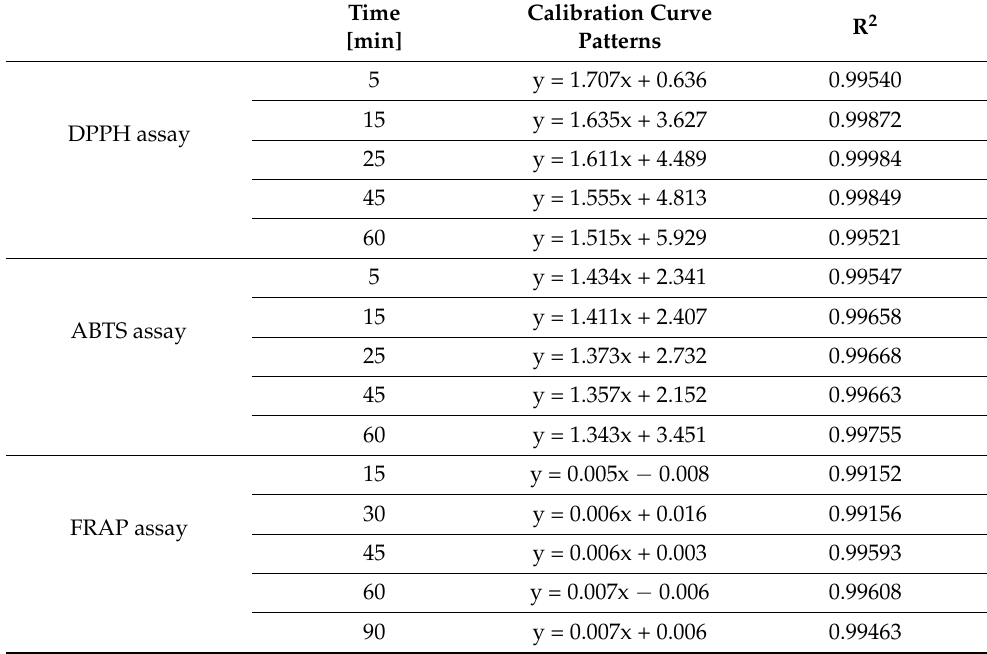
Table 13. Experimental dataset—calibration curves and value of R 2 (for DPPH, ABTS, FRAP assays).